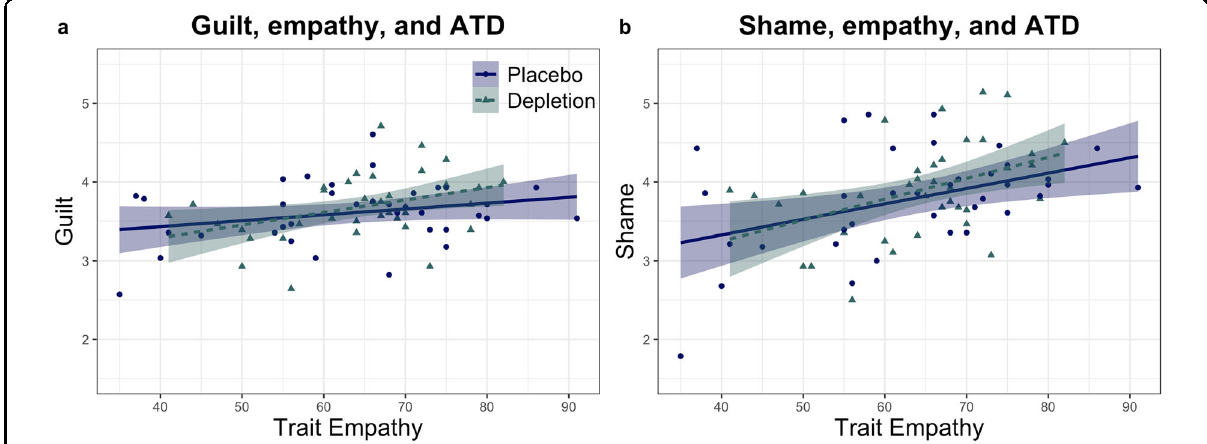
Fig. 2 Effects of trait empathy on how serotonin depletion in fl uences emotion. Shading indicates 1 standard error. Each point represents the average emotion ratings for each individual, collapsed across agency and intentionality. a The highly empathic reported more guilt following depletion relative to when on placebo. b Shame was signi fi cantly elevated in individuals high in trait empathy on both placebo and depletion.